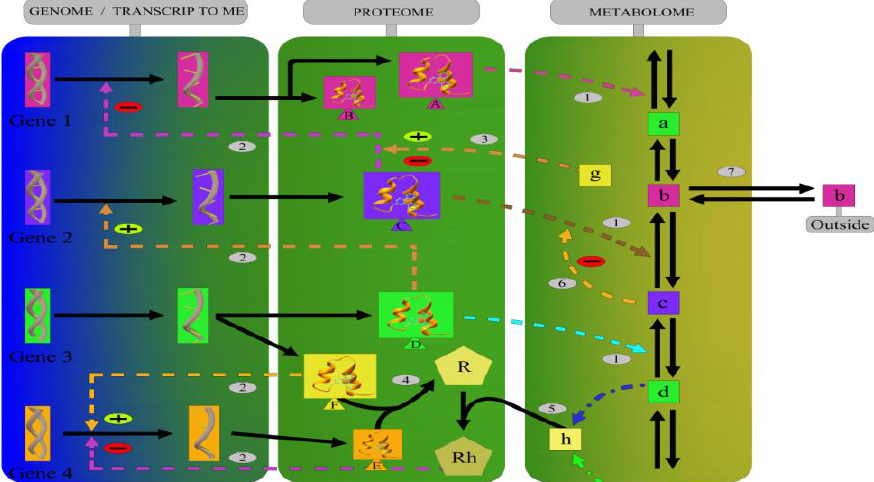
Figure 1. Biological networks represent various types of molecular interactions, including (1) enzyme catalysis, (2) the post-transcriptional control of gene expression by proteins, (3) the effect of metabolites on gene transcription mediated by a protein, (4) protein interactions, (5) the effect of a downstream metabolite on transcription, (6) feedback inhibition/activation of an enzyme by a downstream metabolite, and (7) the exchange of a metabolite outside of the system. The solid lines represent direct interactions, and the discontinuous lines represent possible interactions in tumor